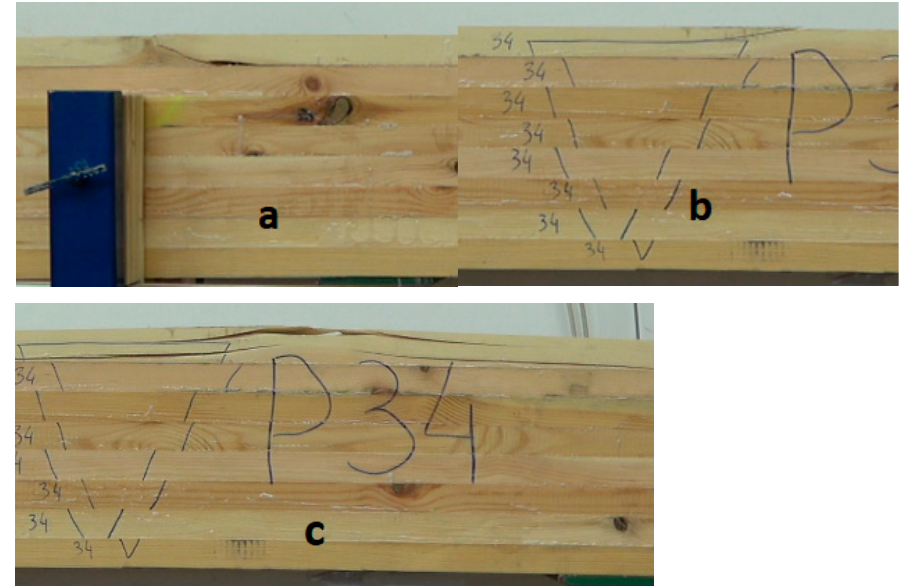
Figure 5. Fracture process of a beam manufactured from pine lumber.